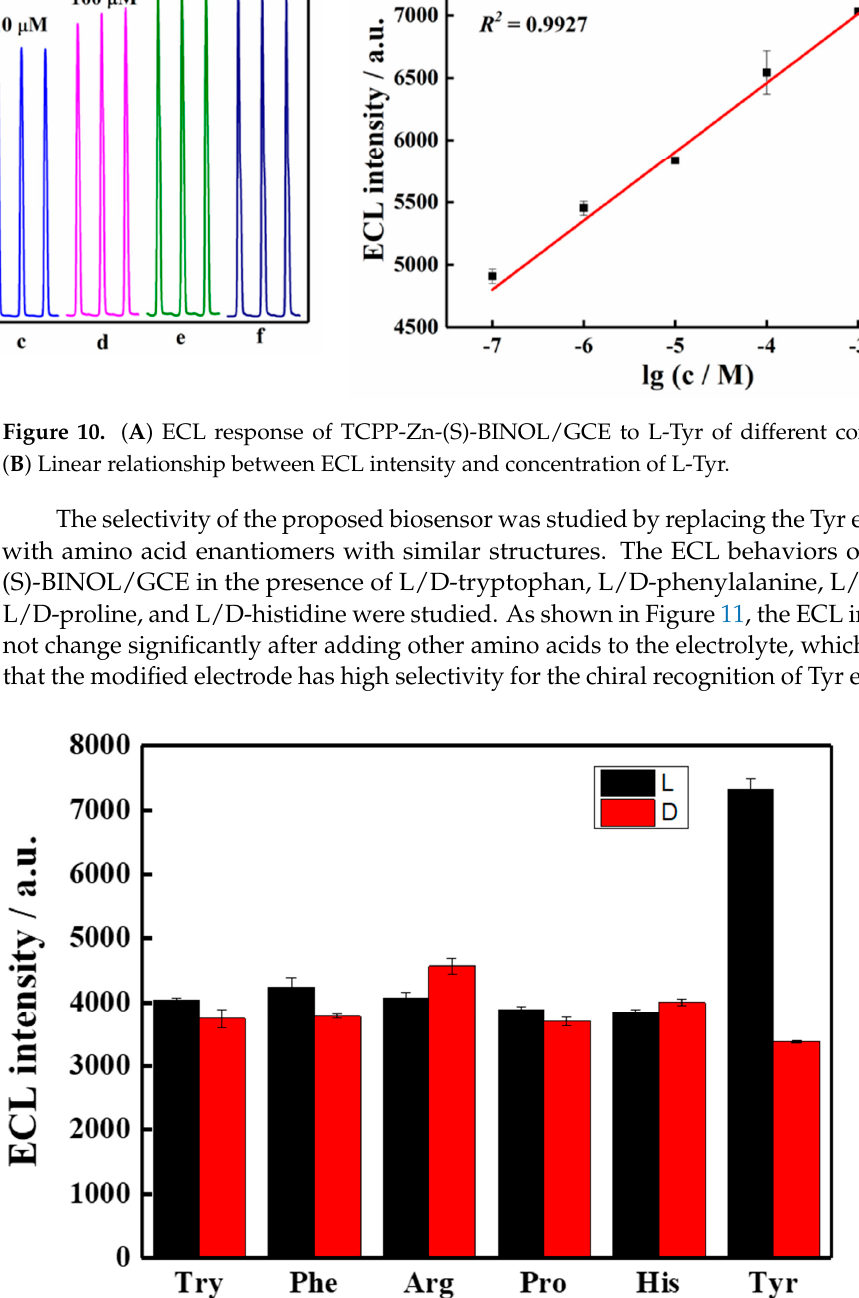
Figure 11. ECL responses for the discrimination of different amino acid enantiomers. 4. Conclusions In this work, (S)-BINOL, as a chiral ligand, was assembled with a Zn-TCPP MOF to construct an efficient ECL chiral sensor. The preparation of porphyrin into an MOF struc- ture can greatly improve its ECL luminescence efficiency, and the introduction of (S)-